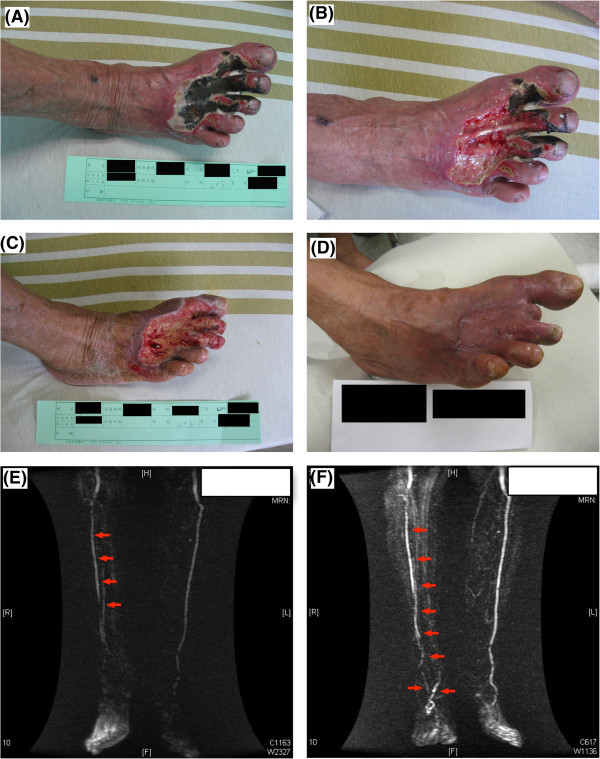
Illustrating the time course of the critical limb ischemia (CLI) in one patient. A) Indicated the wound appearance prior to treatment. B) Illustrated the wound situation by one week after debridement and combined therapy with clopidogrel and cilostazol treatment. C) Indicated the wound situation at one month after the treatment. D) Indicated wound situation by day 90 after the treatment. E) The result of magnetic resonance angiography image (MRA) prior to the combined therapy with clopidogrel and cilostazol showed the poor blood flow and total occlusion of arteries at the level just above the right ankle joint (red arrows). F) By day 90 after the combination therapy, the results of MRA showed that the new angiogenesis/small vessel density and collateral circulations were found to be present (red arrows).